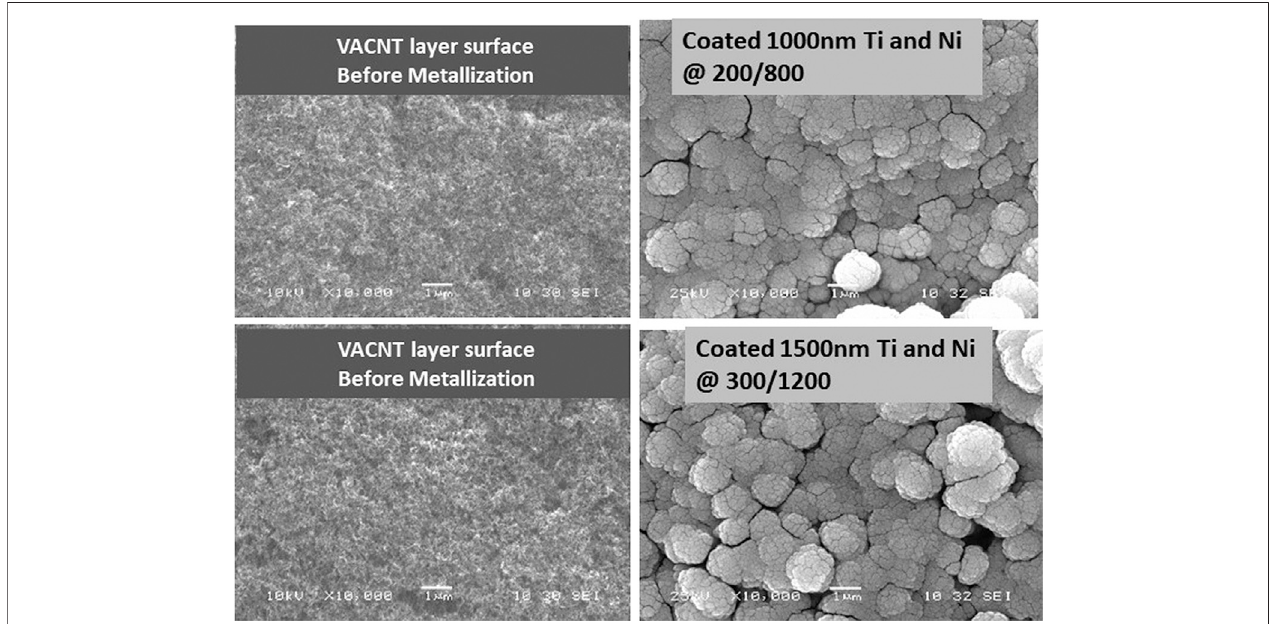
FIGURE 7 | Top view of SEM images: the metalized VACNTs surface by Ti/Ni bi-metal layer. (Scale bar (cid:2) 1.0 µm)